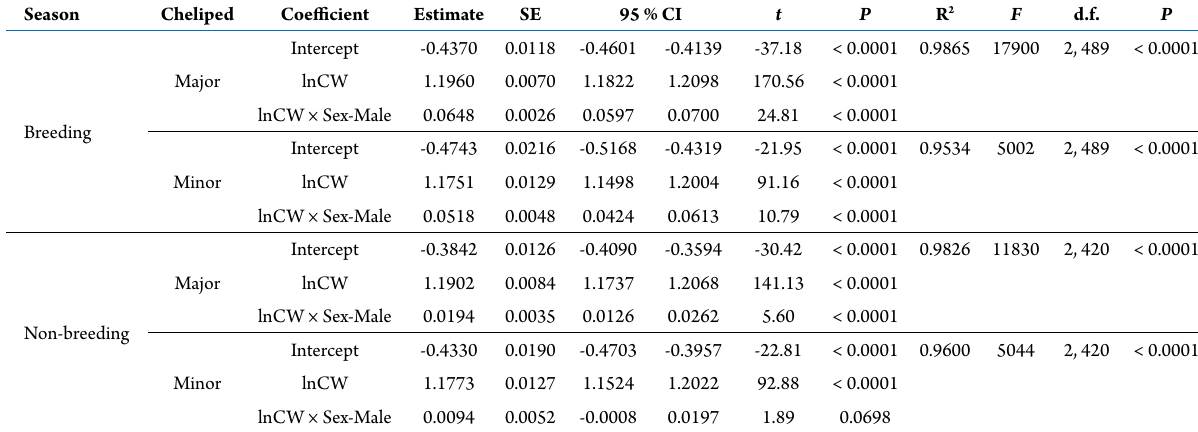
Table A5. Coefficient estimates with standard errors (SE) and their 95 % confidence intervals (CI) for the explanatory variables of log-transformed allometric growth equation models to evaluate the intersexual chela size dimorphism of major or minor chelipeds in the breeding (May to September) and non-breeding seasons (October to April) of the porcellanid crab Petrolisthes japonicus . The linear equation model was as follows: lnChS ~ ln a + b lnCW + c lnCW × Sex, where ChS is the chela size (geometric mean of the propodus length and width), CW is the carapace width, and Sex is female or male. The coefficient estimate for each explanatory variable, including the Sex, was the output for the male, representing changes in the response variable relative to the baseline category (female). The statistical significance of the coefficient estimates and each model was evaluated with t -tests and F -tests,